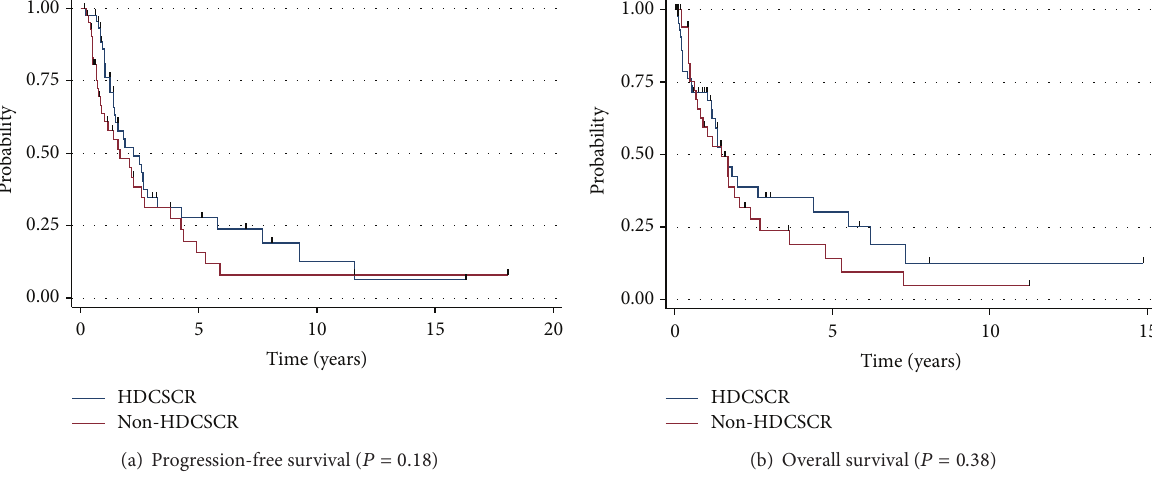
Figure 4: Survival of patients treated with HDCSR or non-HDCSR containing